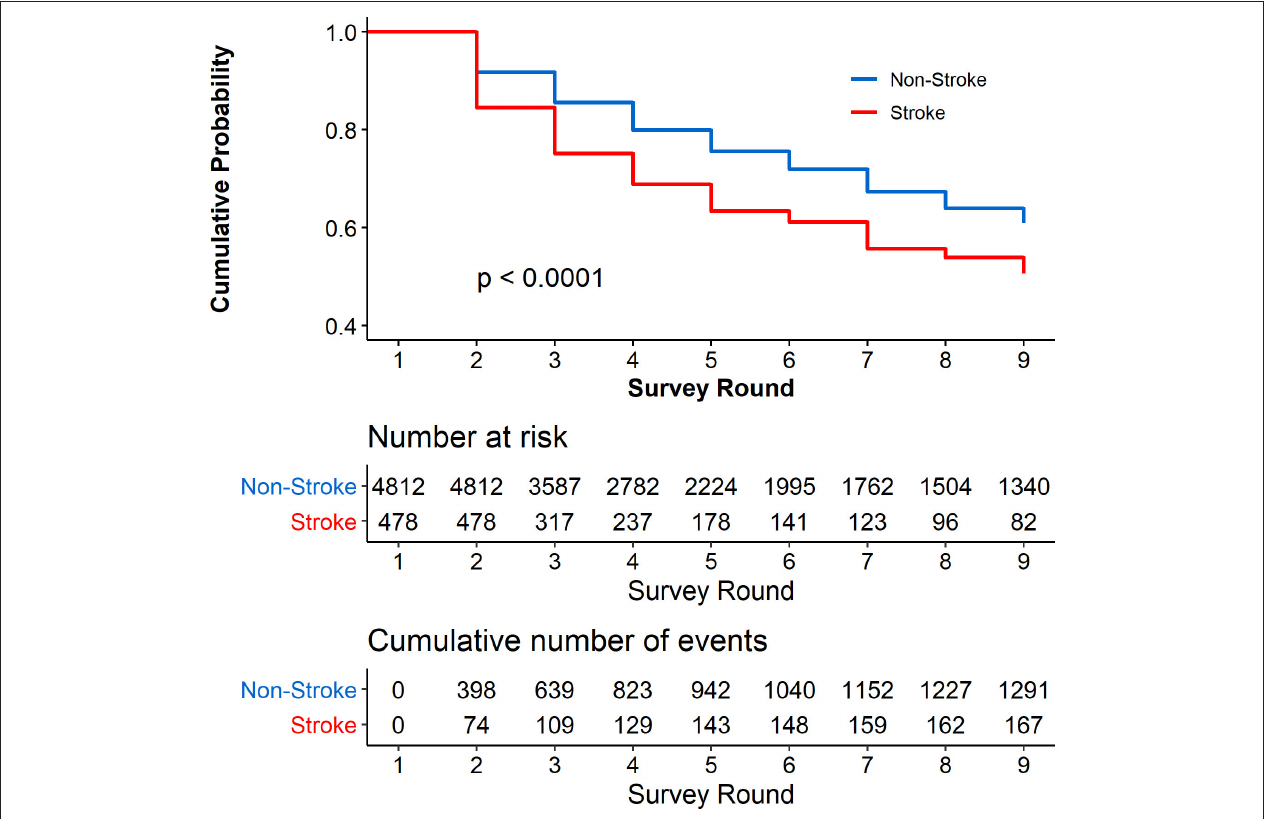
FIGURE 1 | Cumulative Probability of not reporting cognitive impairment during the 8 years of follow-up. Respondents with cognitive impairment at the baseline were excluded ( N =